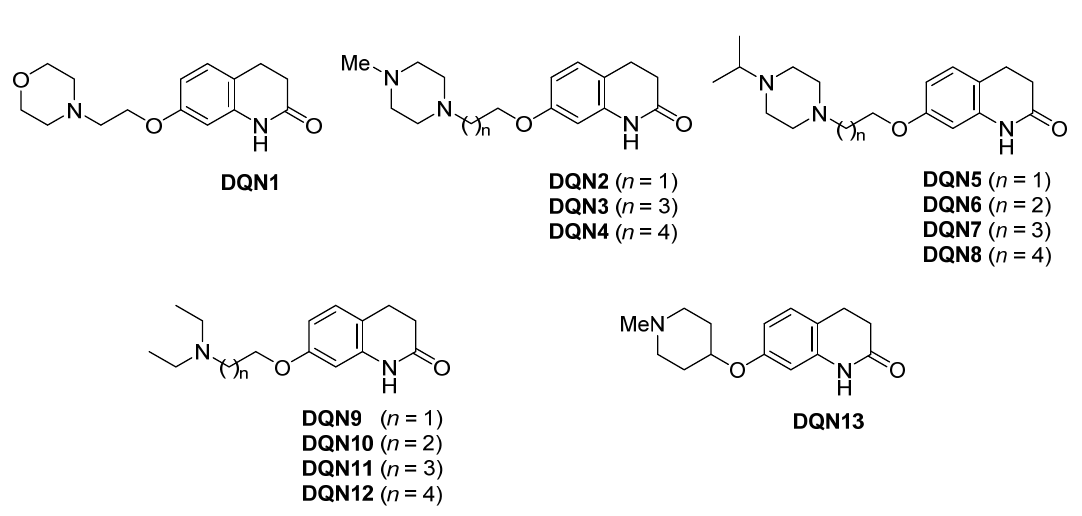
Figure 3. Structures of the “dihydroquinolinones” ( DQN1 ‐ 13 ) described in this work.